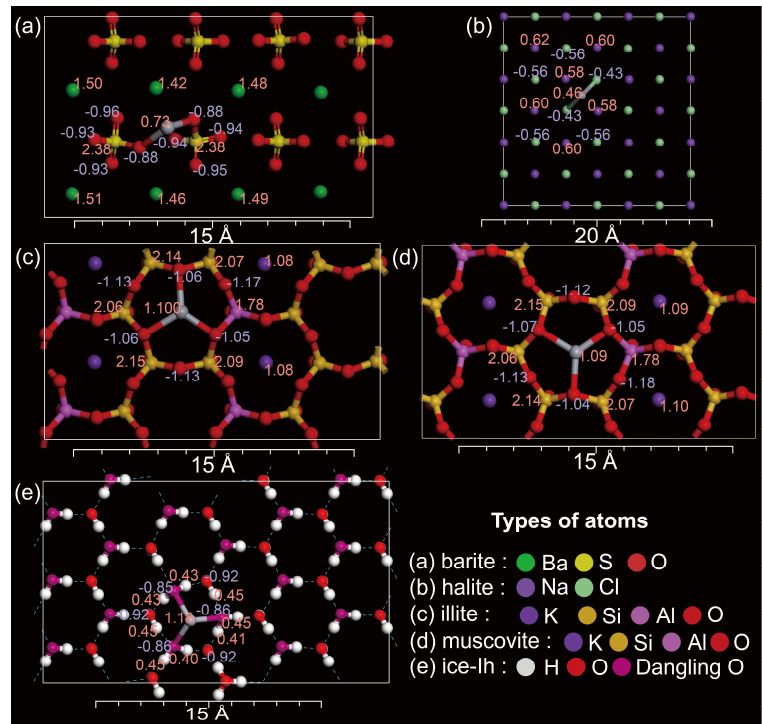
Figure 3. Perpendicular views of the selected cleavage planes with Hg 2+ adsorbed at the most stable sites among the potential sites numbered in Figure 2: ( a ) the barite (001) surface (site 03), ( b ) the halite (001) surface (site 01), ( c ) the illite (001) A2 surface (site 01), ( d ) the muscovite (001) A2 surface (site 01), and ( e ) the ice-Ih (0001) A1 surface (site 01). Only the atoms in the uppermost layers are depicted. Table 2. Calculated binding energies ( E Bind ) for Hg 2+ adsorption on the cleaved surfaces of the selected adsorbents. Negative binding energies implying the stable adsorption of Hg 2+ are shown in italic. Energy